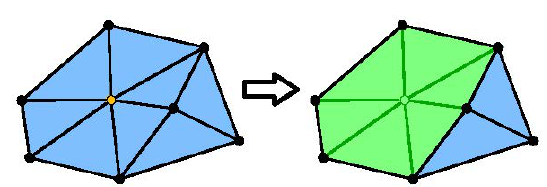
Figure 37: A simplex ( yellow ) and its star ( green ).